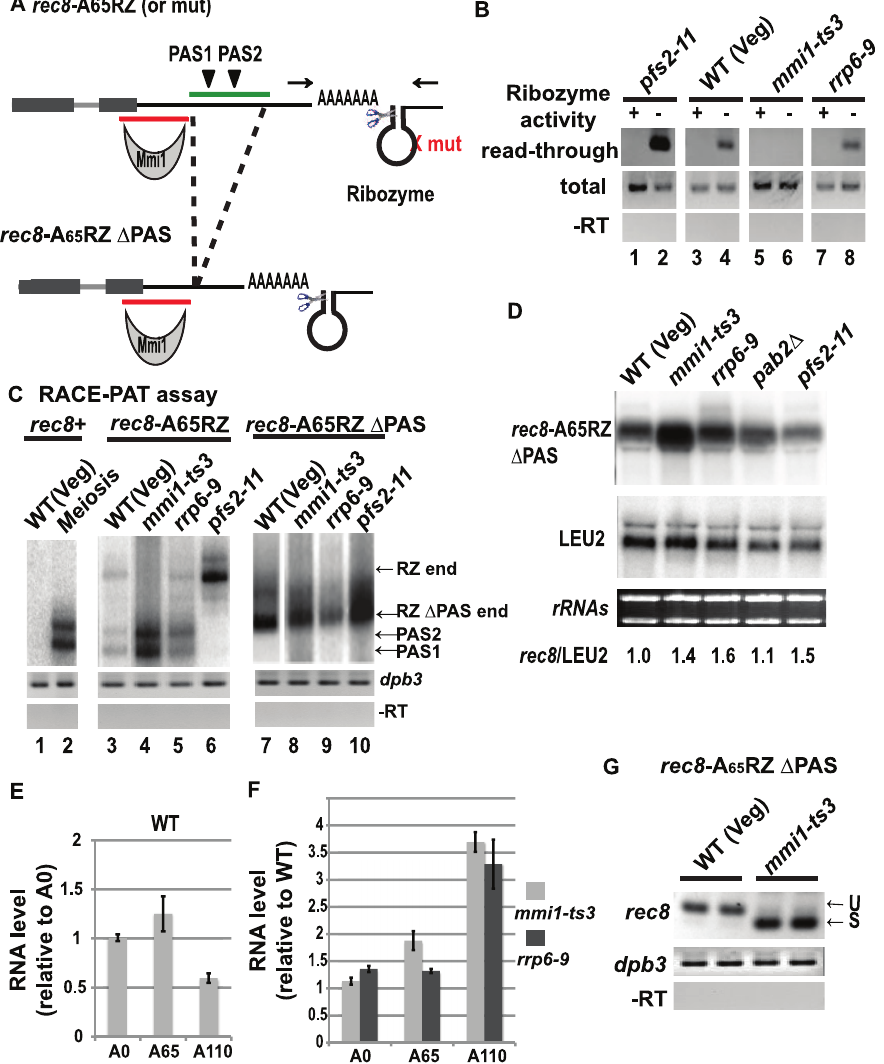
Figure 6. Analysis of ribozyme constructs. A hammerhead ribozyme was placed downstream of rec8 . (A) Illustration of rec8- A 65 RZ and rec8- A 65 RZ D PAS constructs showing the 3’ region of rec8 (boxes show exons, 4 th intron is a line), the DNA-encoded polyA tail, the ribozyme, the DSR (red line), and PAS1 and PAS2. For rec8 -A 65 RZ, 65 A residues (‘‘A 65 ’’) were inserted 91 nt 3’ of PAS2, immediately followed by the hammerhead ribozyme (called RZ and shown as a stem loop). Scissors show the ribozyme self-cleavage site. rec8 -A 65 RZmut is identical except for a point mutation that disrupts ribozyme activity (red cross). Arrows show primers used to detect read-through transcripts. The PAS region (green line) is deleted in the rec8- A 65 RZ D PAS construct. (B) Read-through assay on rec8- A 65 RZ ( + ) and rec8 -A 65 RZmut (-) to measure ribozyme activity and rec8 3’ end cleavage at PAS1 and PAS2. Top panel: read-through assay with primers across the ribozyme sequence. Middle panel: total rec8 measured by primers within the rec8 ORF. Bottom panel: minus reverse transcriptase control. (C) RACE-PAT assay to determine the cleavage sites of polyadenylated transcripts. Left panel: assay on endogenous rec8 + in vegetative and meiotic cells. Transcripts ending at the two major polyadenylation sites are marked PAS1 and PAS2. Middle panel: assay on transcripts of rec8- A 65 RZ in rec8 D strains bearing various mutations. Ribozyme-generated transcripts are marked RZ end. Right panel: assay on transcripts of rec8- A 65 RZ D PAS in rec8 D strains bearing various mutations. Ribozyme-generated transcripts are marked RZ D PAS end. RZ end and RZ D PAS end bands were confirmed by sequencing. (D) Northern blot analysis of rec8- A 65 RZ D PAS in rec8 D strains. Upper panel: level of rec8 transcripts from rec8- A 65 RZ D PAS. Middle panel: LEU2 (expressed from the plasmid) used as a normalization control. Lower panel: ethidium stained rRNAs. rec8-A 65 RZ D PAS to LEU2 ratios are the average of two experiments using independent transformants. (E) Analysis of rec8- A n RZ D PAS constructs with different lengths of encoded polyA sequence, A0, A65 and A110, in rec8 D WT cells. (F) The ratio of each transcript level in the rec8 D mmi1-ts3 mutant to the rec8 D WT and in the rec8 D rrp6–9 mutant to the rec8 D WT. Relative transcript levels are shown on the Y-axis as determined by Q-PCR in triplicate for three transformants of each strain. Error bar represents SEM. (G) Splicing assay on the 4 th intron of rec8- A 65 RZ D PAS in rec8 D WT and rec8 D mmi1-ts3 strains. Results of two independent transformants are shown. Loading control dpb3 and –RT control are shown. doi:10.1371/journal.pone.0026804.g006 based on a comparison of the amounts of read-through product Most of the rec8 -A 65 RZ transcripts end at PAS1 and PAS2, and (RZ band) in wild type versus pfs2–11 mutants (e.g., Figure 6C, not at the ribozyme-generated polyA tail. To increase the number compare lanes 3 and 6, RZ end, and data not shown). of transcripts that have a polyA tail generated by the ribozyme, we